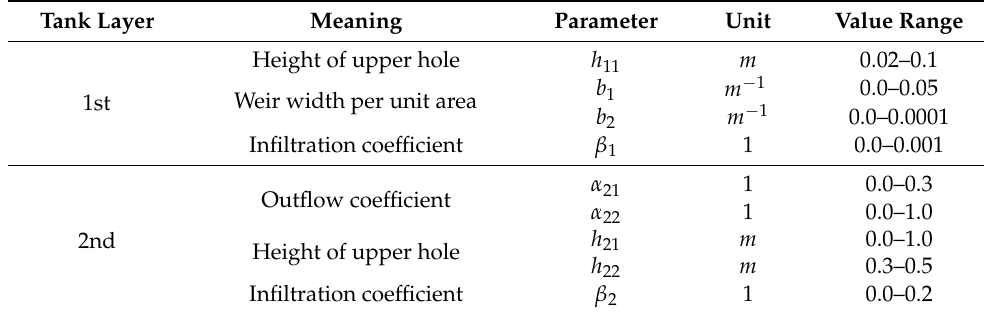
Table 1. The parameters of the model that had to